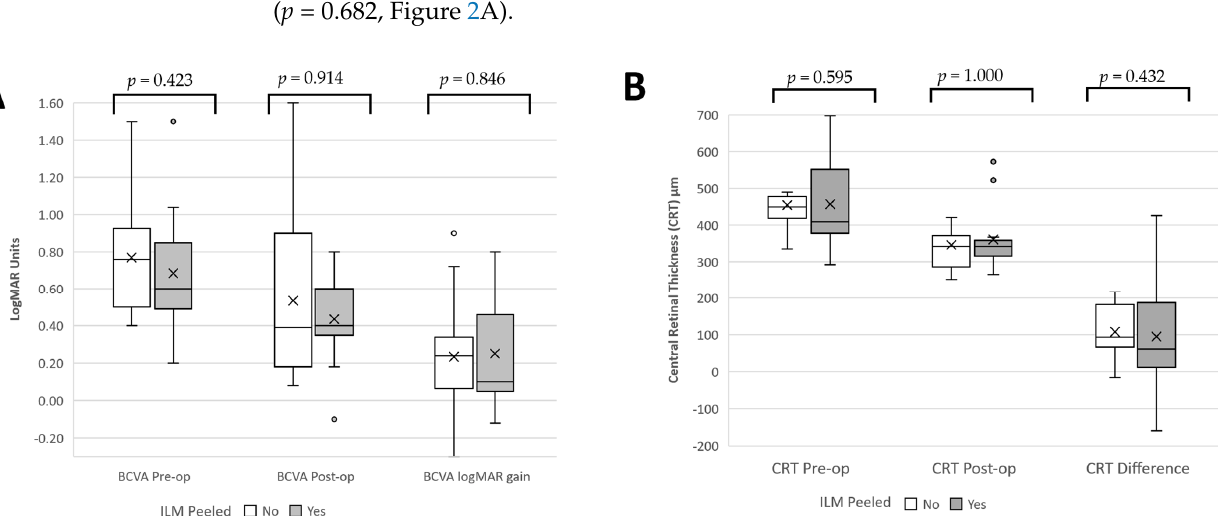
Figure 3. Macular OCT before ( A ) and 6 months after ( B ) vitrectomy and epiretinal membrane peel in a 71 ‐ year ‐ old patient diagnosed with chronic anterior uveitis. The rate of eyes with concomitant CME decreased from 19 (66%) eyes preoperatively to 12 (41%) eyes at six months ( p = 0.065) and 8 (28%) eyes at final follow ‐ up ( p = 0.003). We performed subgroup analysis on eyes with residual CME at six ‐ month FU aiming to assess the potential beneficial impact of surgery on logMAR gain and CRT reduction. We